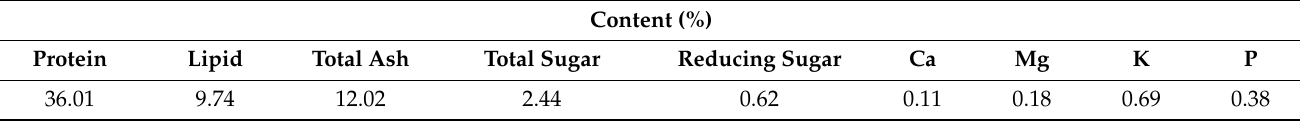
Table 1. The nutrient content of groundnut cake (GNC).